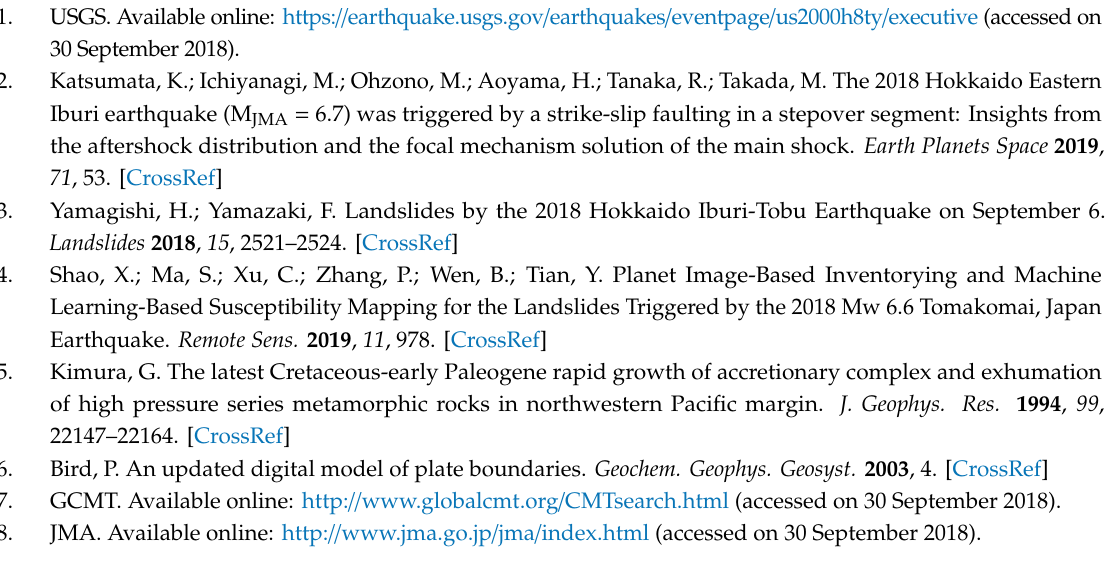
Figure S1: The coseismic interferogram obtained from ascending Sentinel-1A T068A track. The interferogram is rewrapped with an interval of 12 cm, Figure S2: The 2.5D (quasi-eastward (a) and quasi-upward (b)) surface deformation field derived from decomposing ALOS-2 ascending and descending interferograms. The white star represents the main shock and the black square indicates the 0141 GPS Station, Figure S3: The downsampling results from the T046D (a), P018D (b) and P112A (c) track images based on the resolution-based quadtree sampling approach. The red rectangles indicate the regions corresponding to the maximum slip uncertainties produced during the inversion. The red star denotes the epicenter of the main shock, Figure S4: The mean values ( µ ) and standard deviations ( σ ) of the fault parameters calculated by the Monte Carlo method, Figure S5: The 3D distributed slip model. The magenta dots indicate the relocated aftershocks within ~2 days after the main shock, Figure S6: (a) The maximum slip uncertainty corresponding to Figure 6 that was used for forward modeling. (b) The forward modeling interferogram. The maximum slip uncertainty of the fault plane corresponds to the observations from (~42.50 ◦ N, 142.05 ◦ E). The red star denotes the epicenter of the main shock. The surface trace of the fault is from the distributed slip model of this study, Figure S7: Results of the resolution tests. The resolution tests were carried out assuming a coseismic synthetic slip distribution characterized by slip only on shallow (a–c), middle (d–f), deep (g–i) and classical checkerboard distribution (j–l). The input slip models are (a), (d), (g) and (j), the corresponding inversion models are (b), (e), (h) and (k), and the residuals are (c), (f), (i) and (l), Table S1: The coseismic displacements of 20 GPS stations derived from static GPS solutions, Table S2: Constraints on the fault geometry for the nonlinear inversion, Table S3: The slip distribution on each patch of the inferred fault